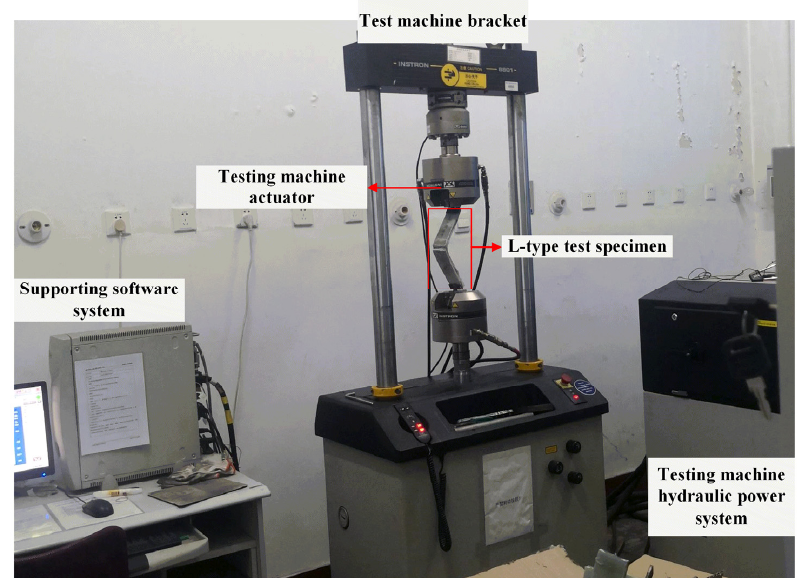
Figure 5. Compression test of metal-composite L-joint and direction of force.